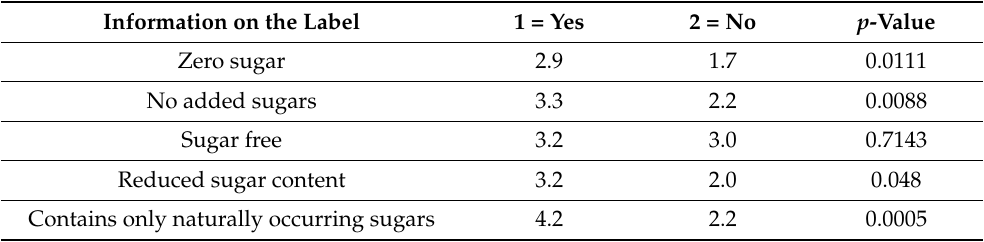
Table 6. Declaration on choice of the food product depending on the available information indicating the sugar level.